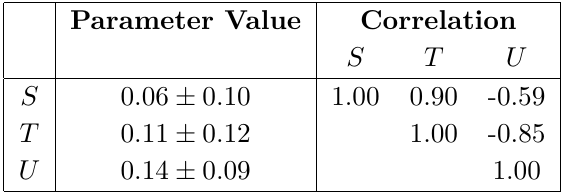
Table 2 . Values of the S , T , and U parameters along with their correlation matrix allowed by the electroweak fit including the W boson mass as measured by the CDF collaboration [43].